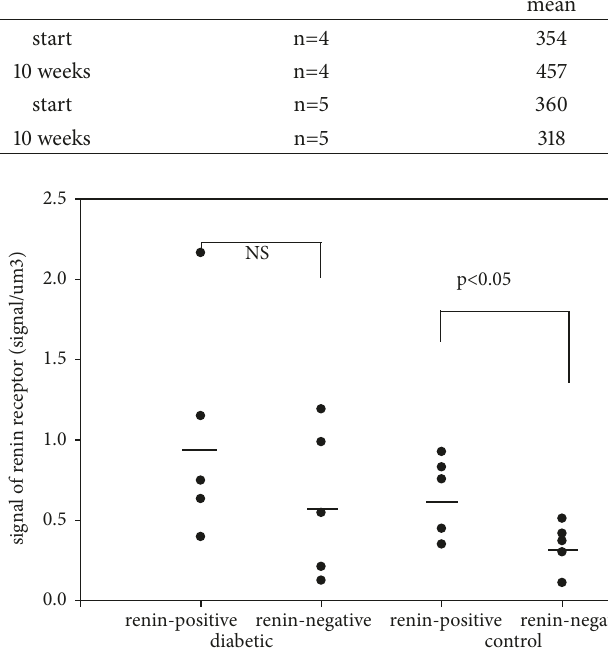
Figure 1: The number of renin receptors on the surface of afferent arteriolar SMCs.